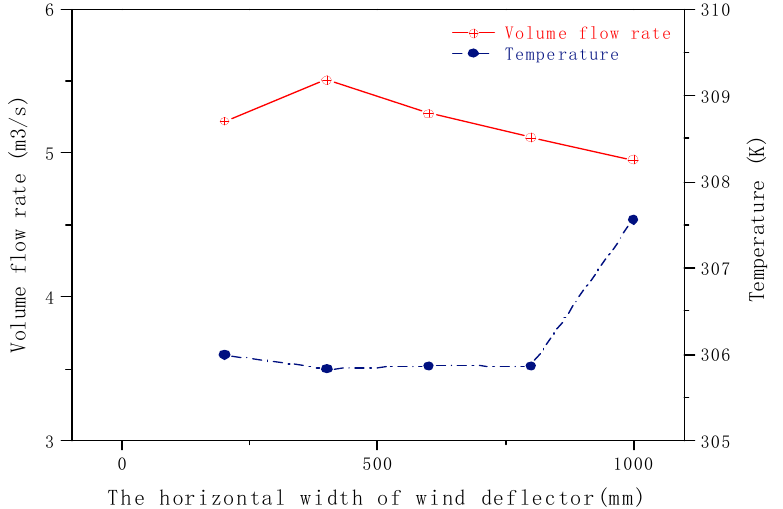
Figure 11. Values of volumetric flow and temperature at different horizontal widths of the wind deflector.